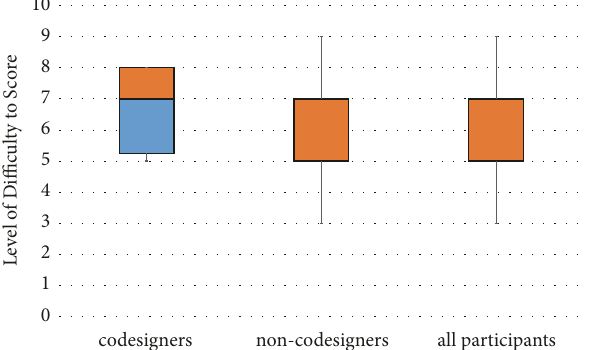
Figure 14: ITC score boxplot graphics: the graphs compare the dispersion of results from the immersion level for the codesigners and noncodesigners in the game. The ITC score was formed by the average of grades from topics 1 to 10 of Table 9.